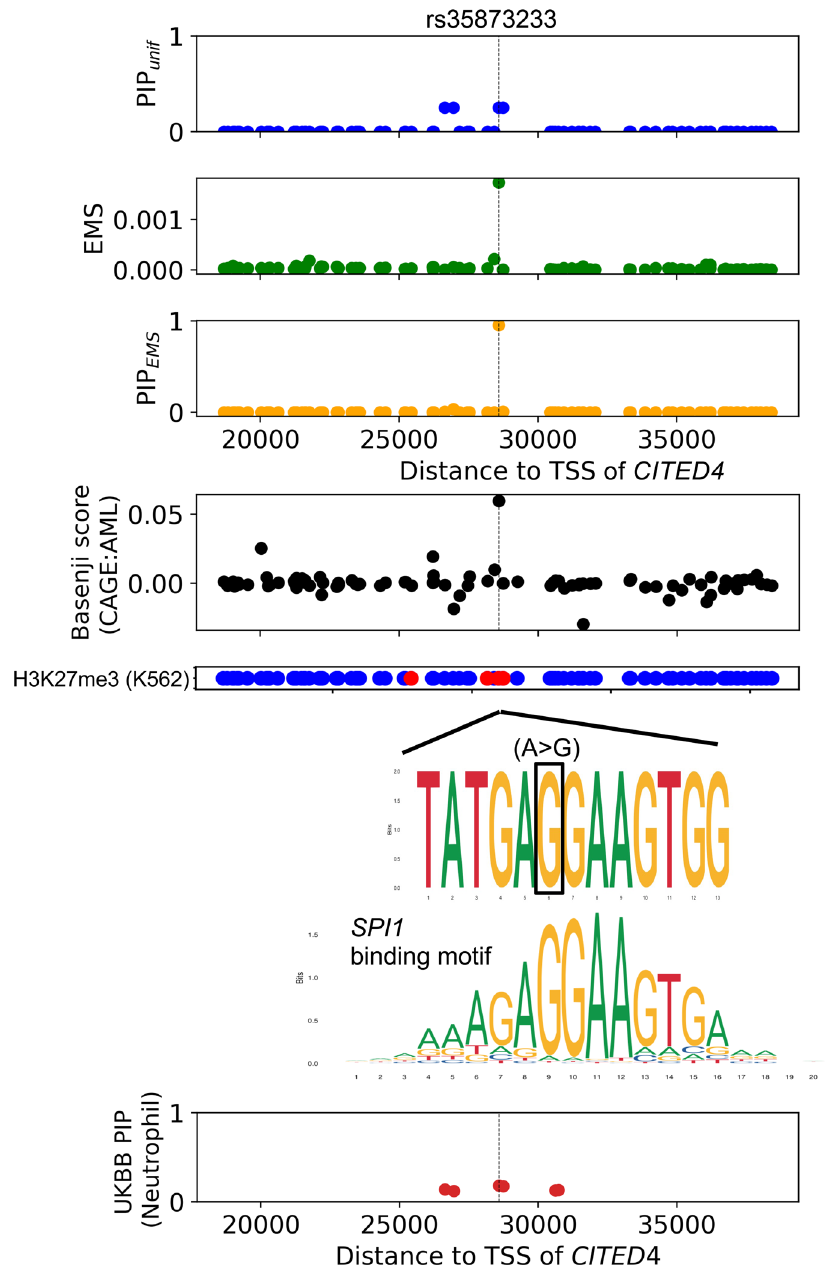
Fig. 6 An example of a putative causal eQTL prioritized by EMS. rs35873233, an upstream variant of CITED4 , was prioritized by functionally informed fi ne-mapping using EMS as a prior. From top to the bottom: PIP with uniform prior (PIP unif ), EMS, PIP with EMS as a prior (PIP EMS ); Basenji score for CAGE 46 activity in acute myeloid leukemia (AML), H3K27me3 narrow peak in K562 cell line (red if the variant is on the peak, blue otherwise), sequence context 60 of the alternative allele aligned with the binding motif 61 of SPI1 , and PIP for neutrophil count in UKBB (https://www. fi nucanelab.org/data, ref. 34 ) with uniform